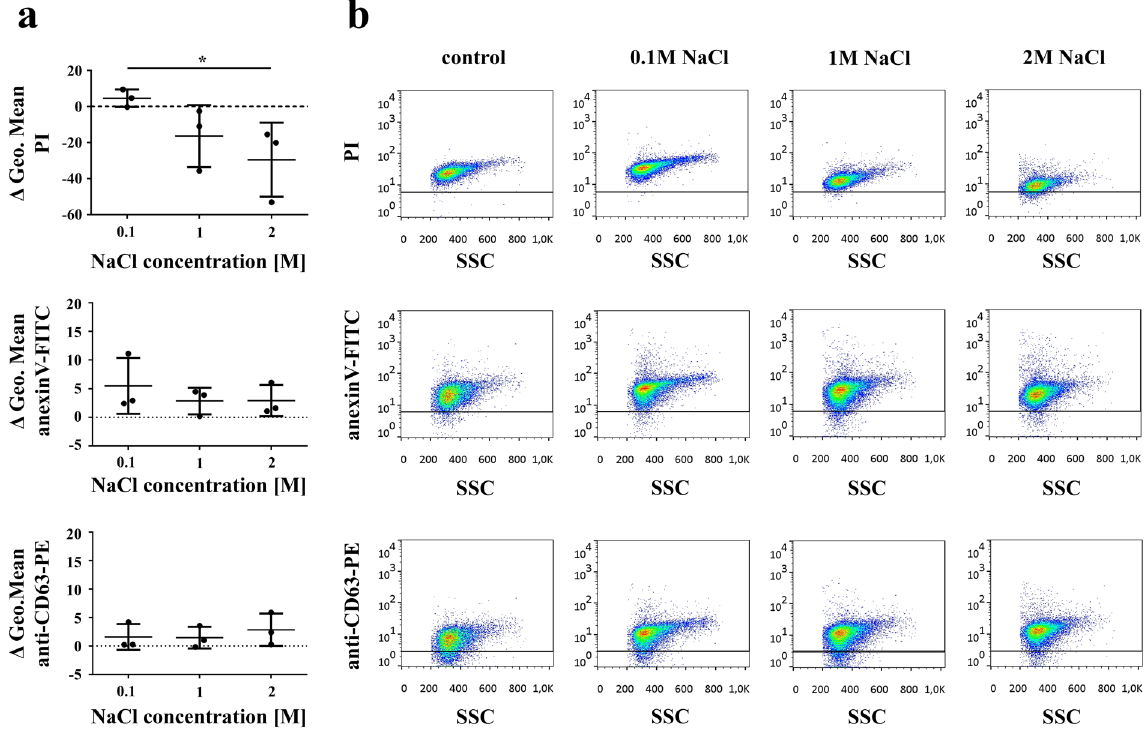
Figure 3. Association of DNA with EXO surface is abolished by high salt concentration. Ciprofloxacin-exposed Jurkat cell exosomes (EXOs) were conjugated onto latex beads and washed using annexinV binding buffer supplemented with 0.1 M, 1 M or 2 M NaCl. All latex-bound EXO samples were re-suspended in annexinV binding buffer, and labeled with propidium iodide (PI), annexinV-FITC and an anti-CD63-PE antibody for flow cytometry. (a) Differences of geometric mean fluorescence values between EXOs washed in high salt concentration buffers and controls are shown. Plotted values are presented as the mean + / − S.D. (error bars) of three independent experiments. * P < 0.05, Friedman test, One-way ANOVA (b) Density plots